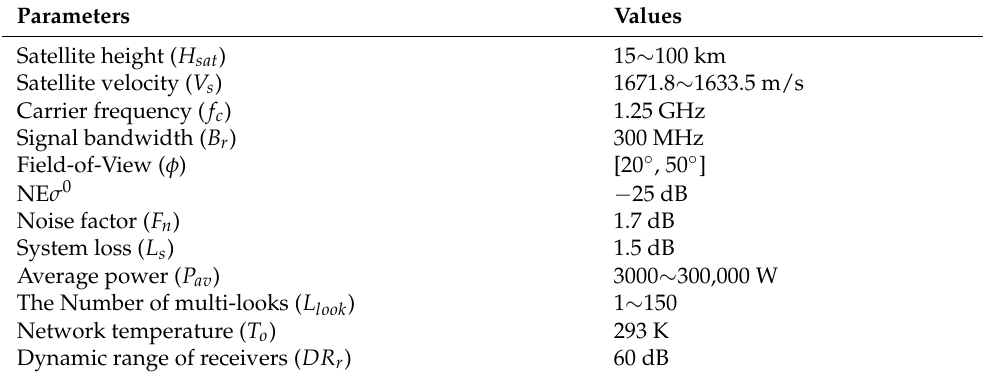
Table 2. The system parameters used for the simulation experiments to evaluate the influence of the incidence angle, the number of multi-looks, transmitting power, quantization accuracy of receivers, and so on on the design of spaceborne SAR system for lunar water ice exploration. Parameters